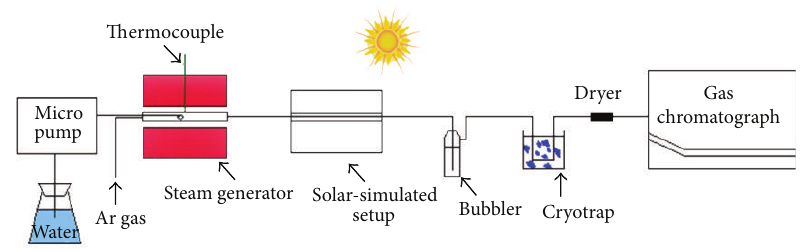
Figure 2: Experimental flow